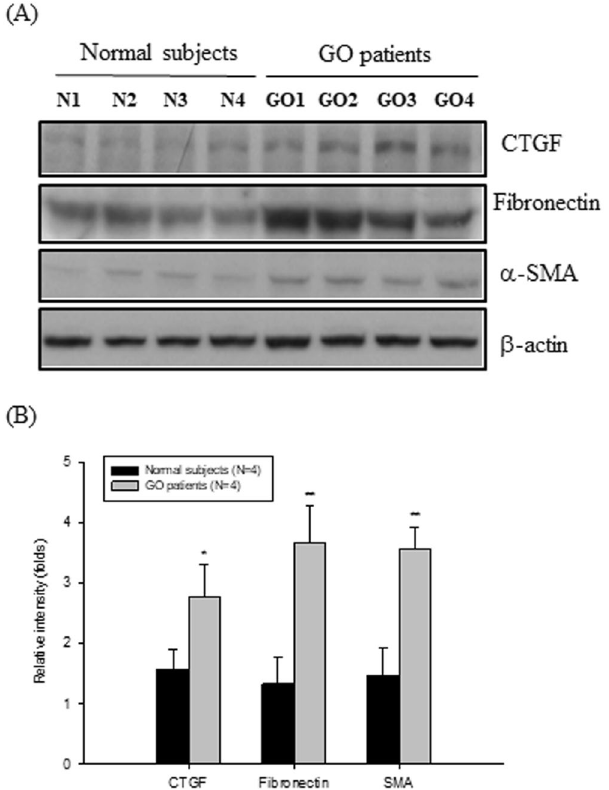
Figure 1. Up-regulation of fibrosis-related proteins in GO orbital fibroblasts as compared to those of normal subjects. ( A ) By Western blots, the fibrosis-related proteins including CTGF, fibronectin and α -SMA were observed in the orbital fibroblasts from four GO patients (GO1-GO4) and four normal subjects (N1-N4). ( B ) By three independent Western blots experiments, we averaged together data from the same normal and patient strain, and then averaged the means of the different normal and patientstrain. The representative histogram was constructed on the basis of the mean values of proteins expression levels in orbital fibroblasts of normal subjects and GO patients, and presented as means ± S.D. ( * p < 0.05 vs. normal subjects; ** p < 0.01 vs. normal